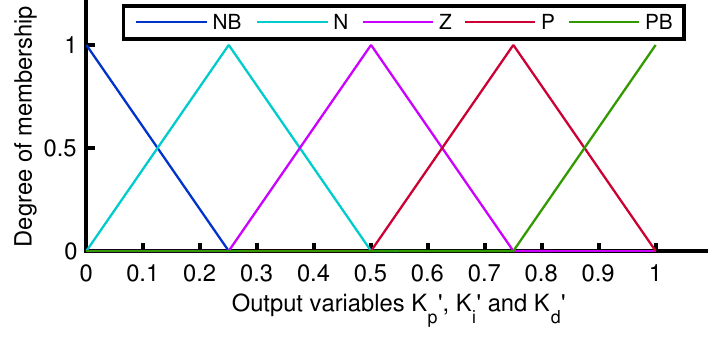
Figure 8. The outputs membership functions. Table 1. Fuzzy rules for K p gain [30].